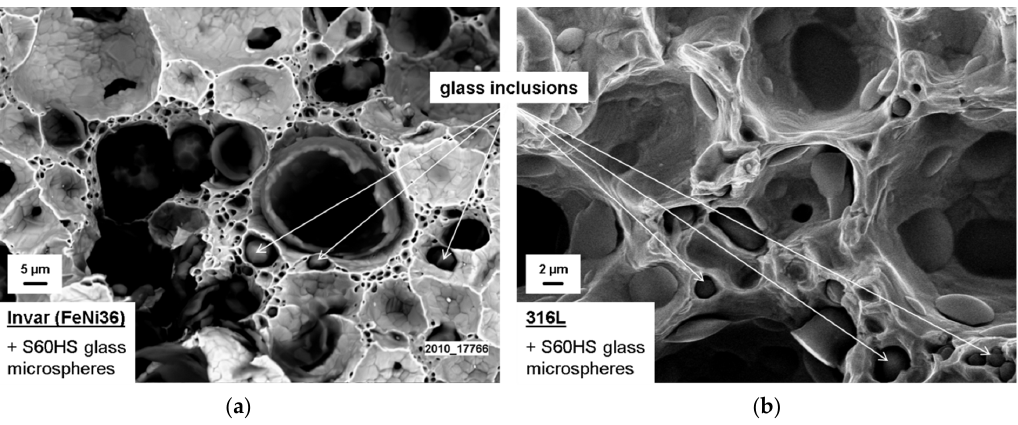
Figure 2. SEM images of fracture surfaces of SFs based on glass microspheres with matrices of Invar (FeNi36, ( a )) and 316L ( b )—glass inclusions within the matrix are visible in both cases. S60HS represents S60 hollow glass microspheres manufactured by 3M, St. Paul, MN, USA [24].